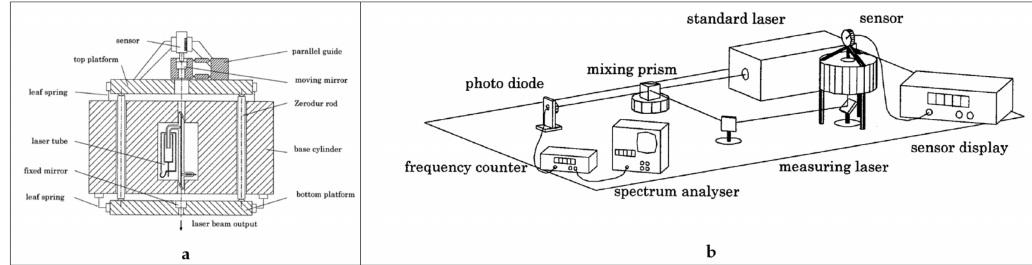
Figure 7. Schematic cross section of a He–Ne measuring laser ( a ) and overview of the calibration set-up ( b ). Courtesy of S. Wetzels.